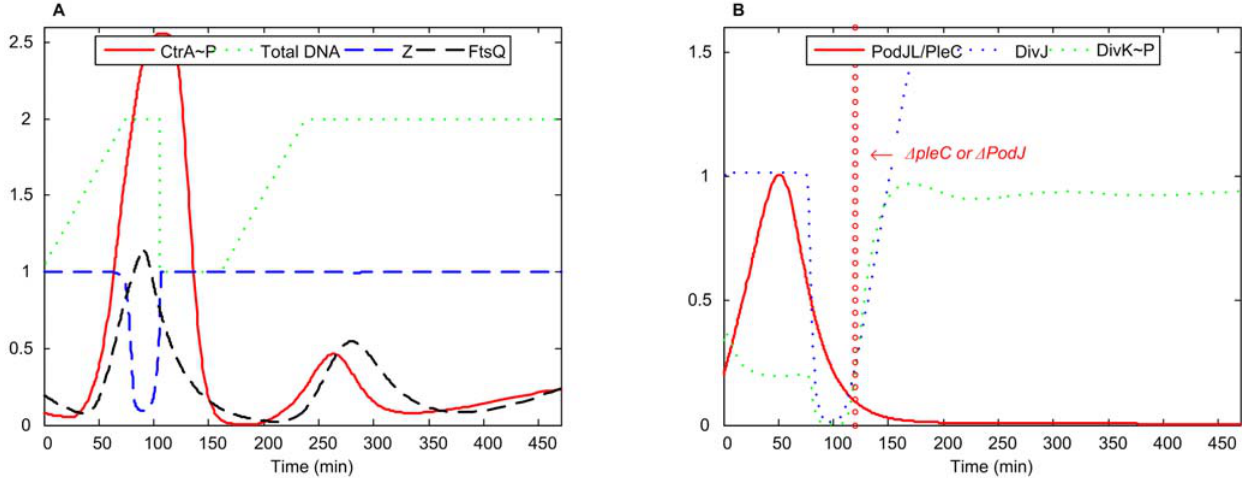
Figure 11. Simulation of D pleC / D podJ mutants. k s,PodJL =0.